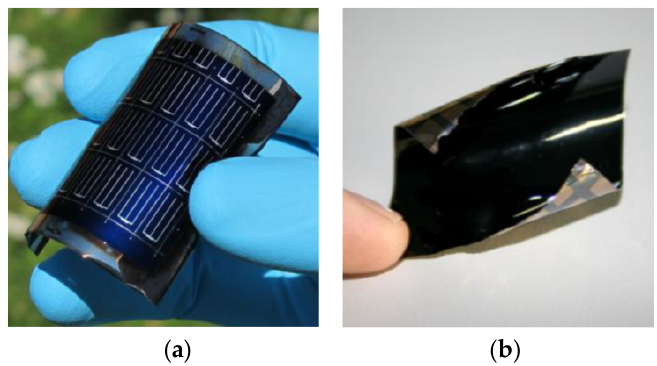
Figure 14. Flexible CIGS ( a ) and CdTe ( b ) solar cells on polyimide substrates [63].